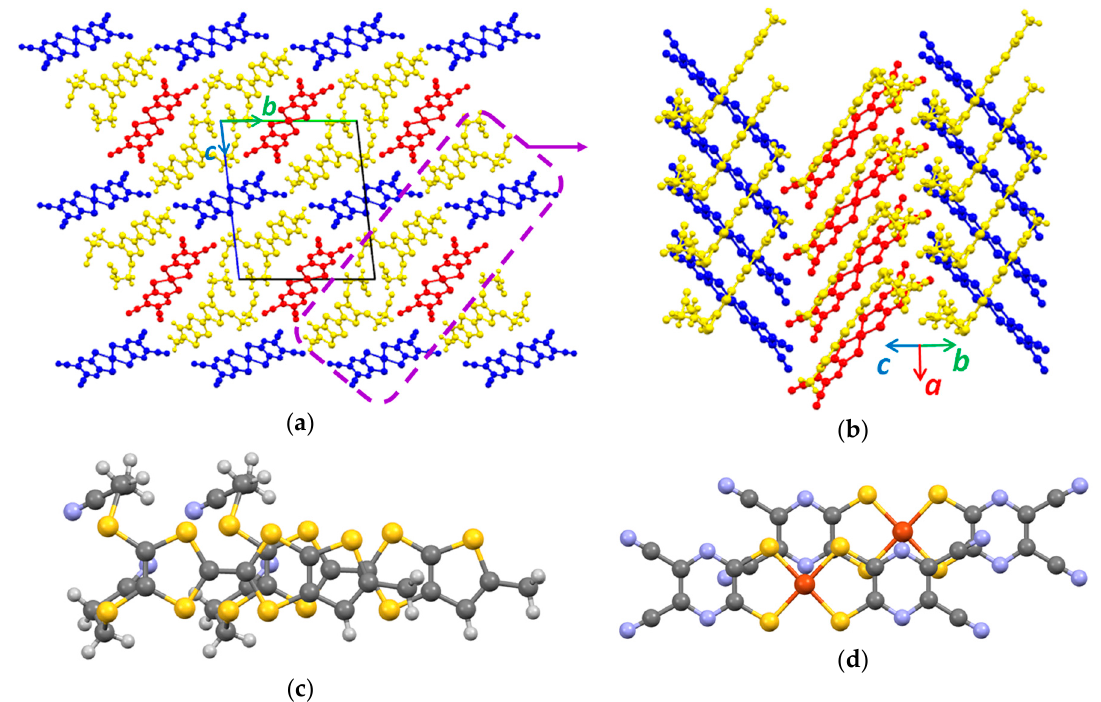
Figure 7. ORTEP and atomic numbering schemes (top and side views) of α -mtdt donor ( a ) and acceptor [Cu(dcdmp) 2 ] molecules A ( b ) and B ( c ) in the crystal structure of ( α -mtdt)[Cu(dcdmp) 2 ] ( 7 ), with thermal ellipsoids drawn at 50% probability level.